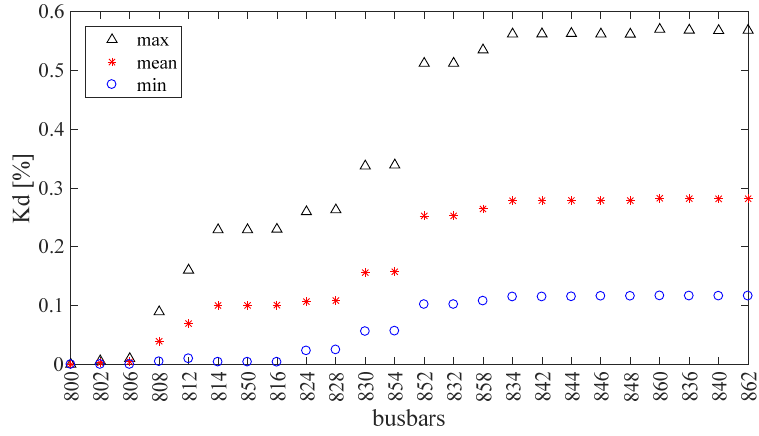
Figure 7. Minimum, mean, and maximum values of unbalance factor at all three phase buses (in one year).